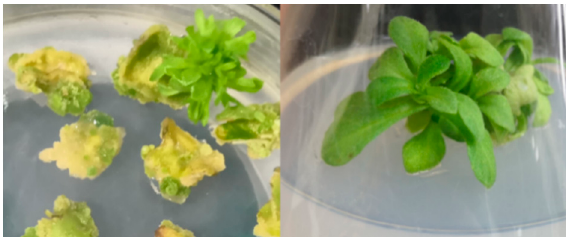
Figure 3. Developmental stages and screening of CmTFL1a transgenic plants of chrysanthemum cv. Jinba. Callus regeneration after 2 weeks on selection medium containing meropenem (50 mg L −1 ) and kanamycin (7 mg L −1 ). Induction of resistant adventitious shoots after 3 weeks. Kanamycin resistant shoots with large green leaves after 4 weeks.